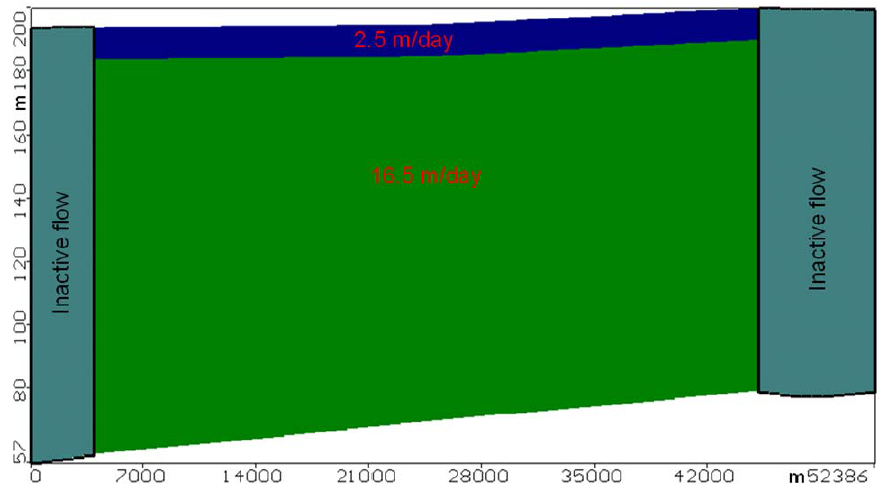
Figure 2. Aquifer subsurface conceptualization with aquifer conductivity ( x - and y -axes are in m).